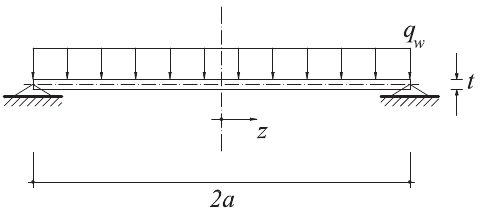
Figure 7. Simply supported circular plate subject to uniform pressure. Cross section.